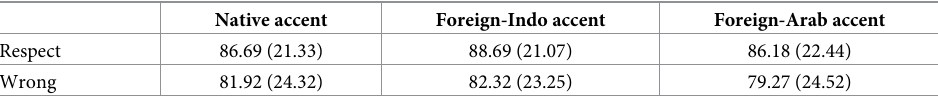
Table 6. Mean scores (SD) for Respect and Wrong across Accent (native, foreign-Indo, and